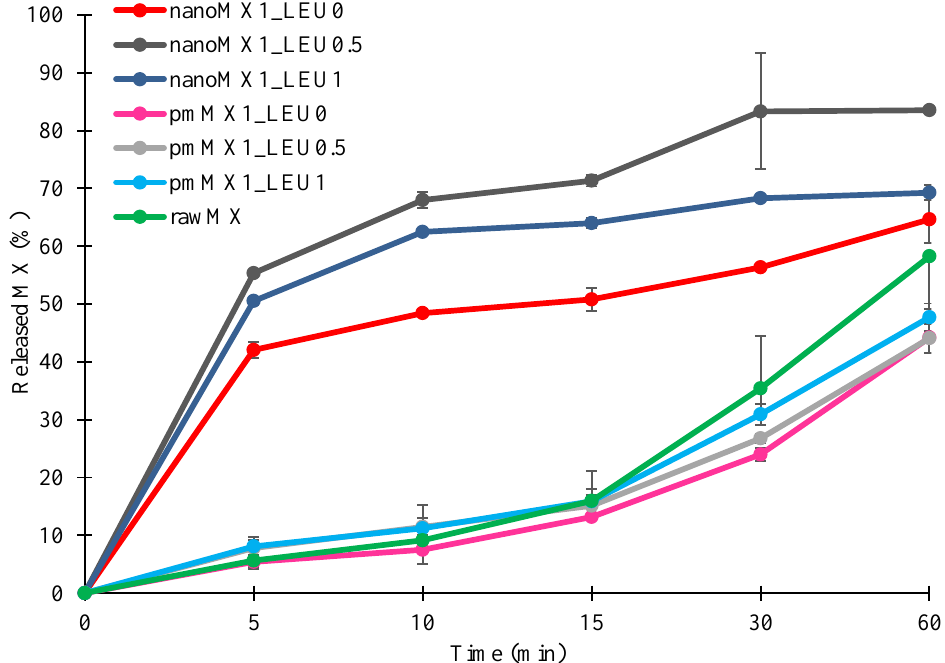
Figure 4. In vitro dissolution results of the active pharmaceutical ingredient (API) (rawMX), the physical mixtures (pmMX1_LEU0, pmMX1_LEU0.5, and pmMX1_LEU1), and the prepared samples (nanoMX1_LEU0, nanoMX1_LEU0.5, and nanoMX1_LEU1). Data are means ± SD (n = 3 independent measurements).